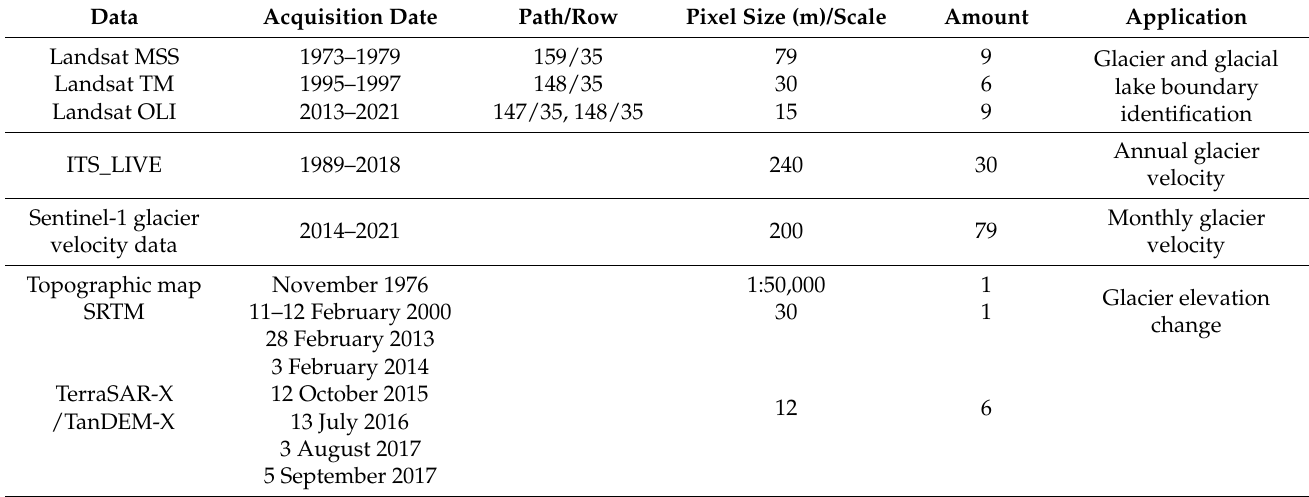
Table 1. Overview of data